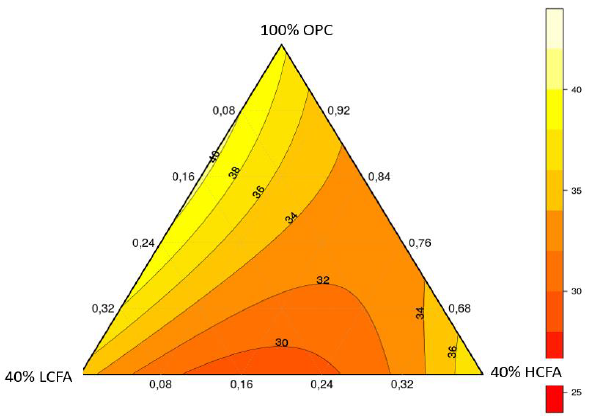
Figure 8: A contour chart for the model from Table 4 for the strength of the samples immersed in sodium sulphate.